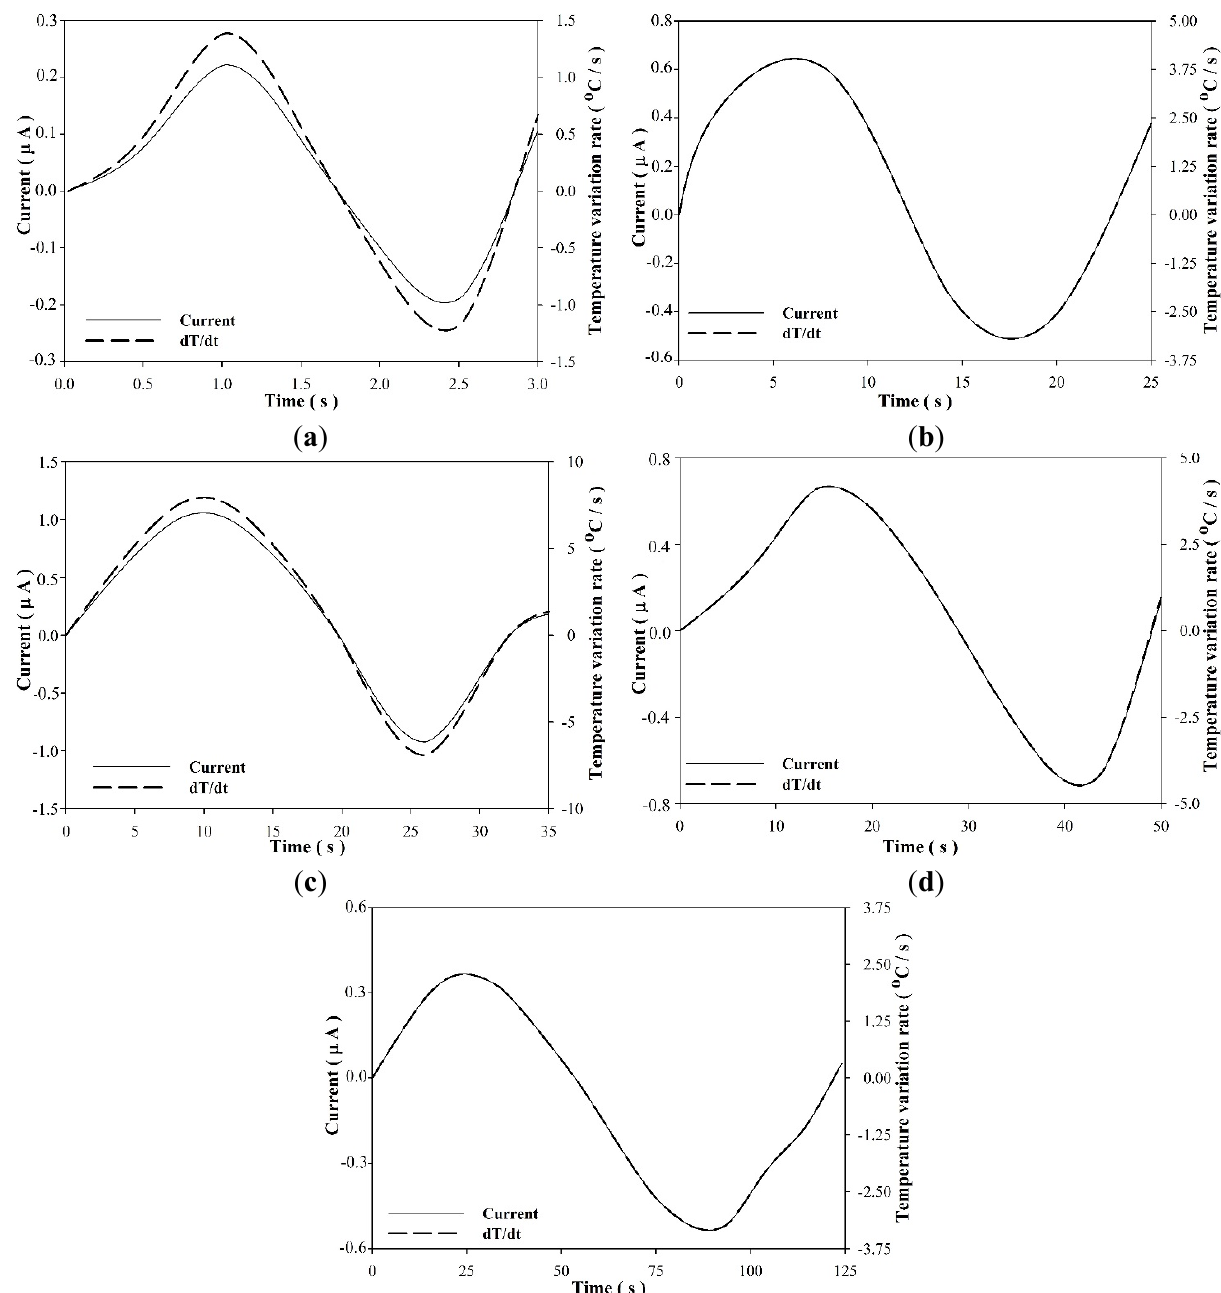
Figure 8. Induced current and temperature variation rate over time at five different period times (2.5 s ( a ); 20 s ( b ); 35 s ( c ); 50 s ( d ); and 125 s ( e )) for the PZT pyroelectric